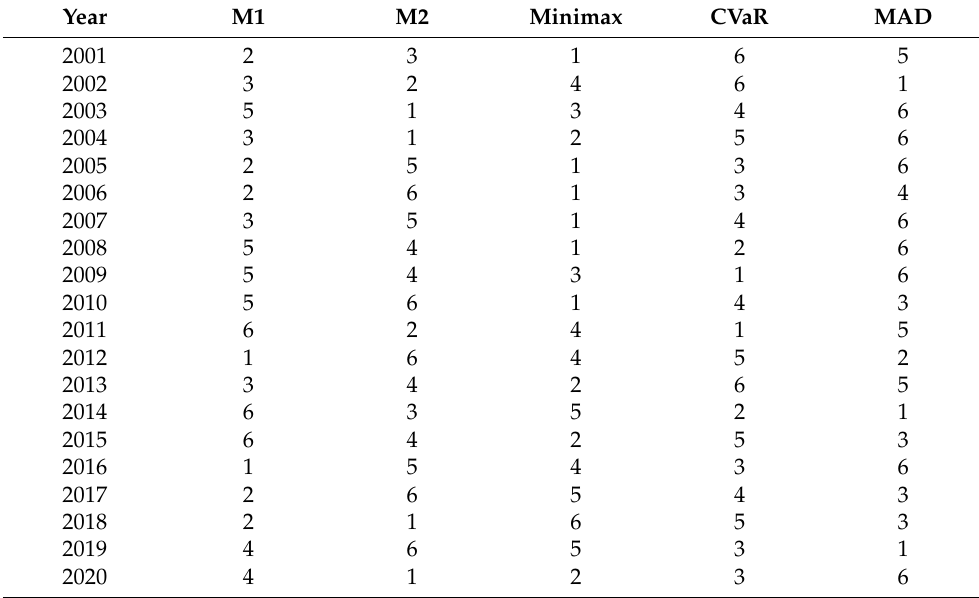
Table A7. Portfolio ranks by Sharpe ratios for each